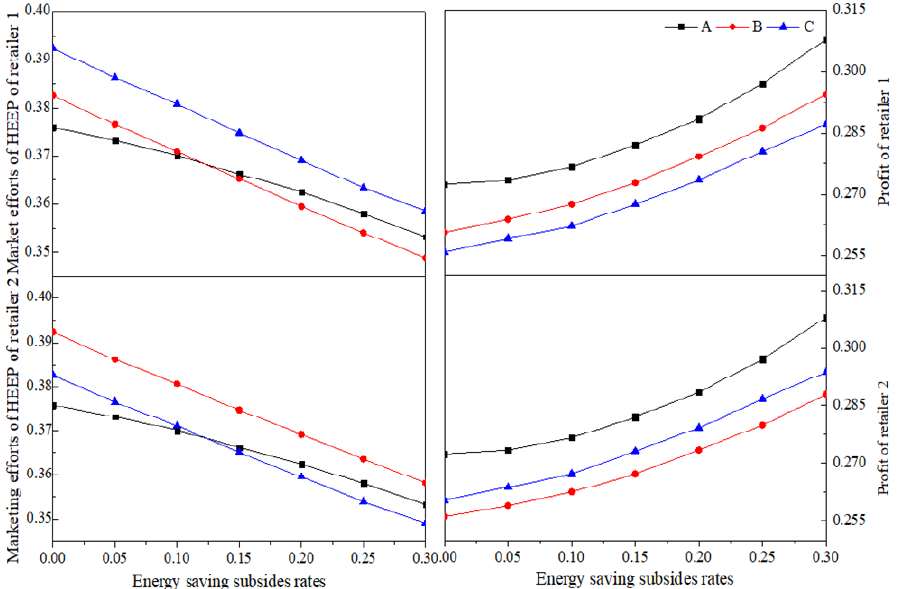
Figure 7. The SCNE results of retailer i ’s profit and marketing efforts for HEEP in different scenarios.